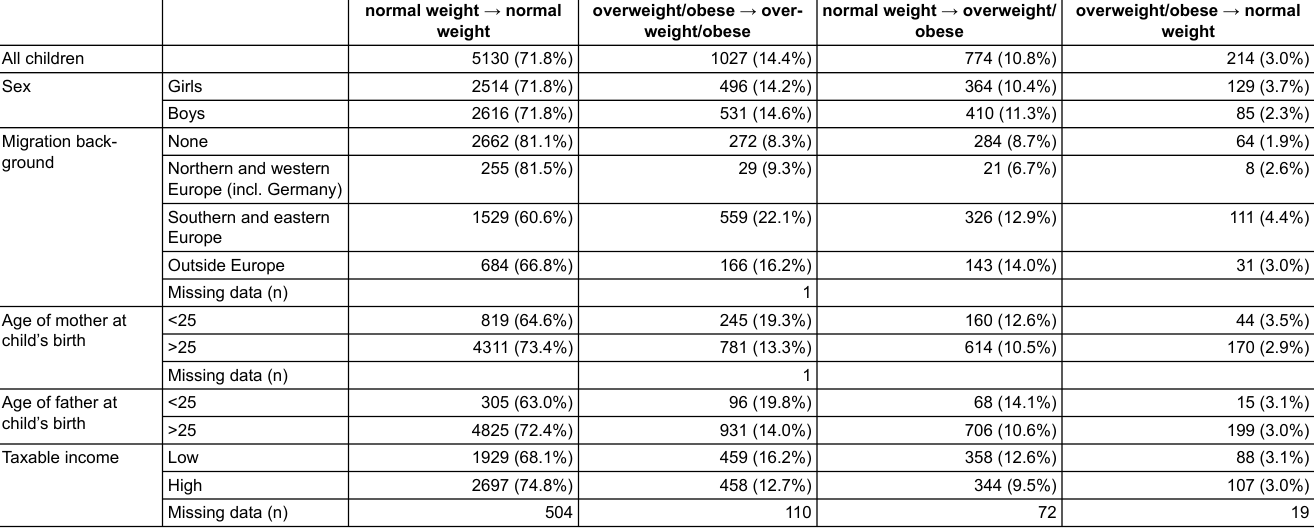
normal weight → normal